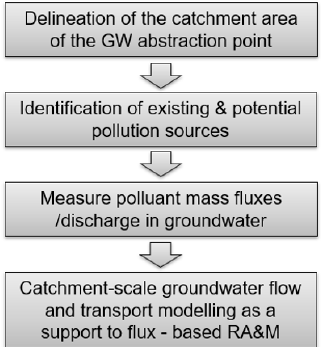
Figure 2. Integrated approach of peri-urban sites investigation (GW = groundwater; RA&M, Risk Assessment and